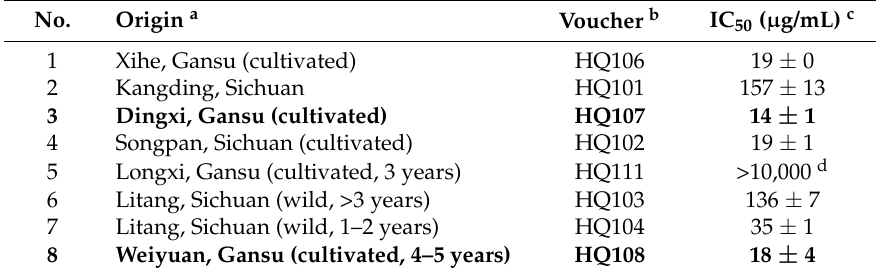
Table 1. Radix Astragali samples investigated and the IC 50 -values determined in the α -glucosidase inhibition assay of ethyl acetate extracts. The three most active extracts are typeset in bold. No. Origin